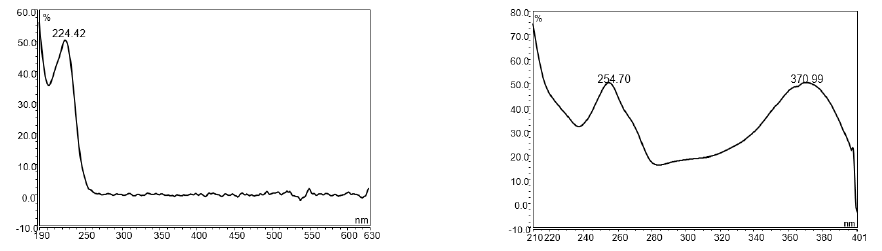
Figure 1. The UV spectrum of glucoarabin ( left ) and quercetin ( right ). In this study, three UPLC columns were selected to compare their separation performance (data not shown). All chromatograms were detected at 225 nm. The gradients were adjusted according to each column’s chemical properties. Waters Acquity HSS T3 column (1.8 µ m, 2.1 × 150 mm) achieved the best separation performance, possibly due